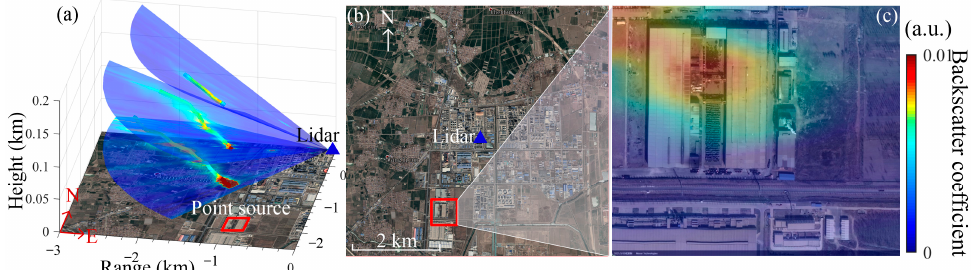
Figure 3. ( a ) The trajectories of smoke plume extracted from Figure 2d–f. ( b ) The red-box region is the tracking result of the point source pollution in Figure 3a. ( c ) The corresponding red box region in Figure 3b. Trajectories of plume are highlighted in ( a ). The blue triangle represents the lidar site.